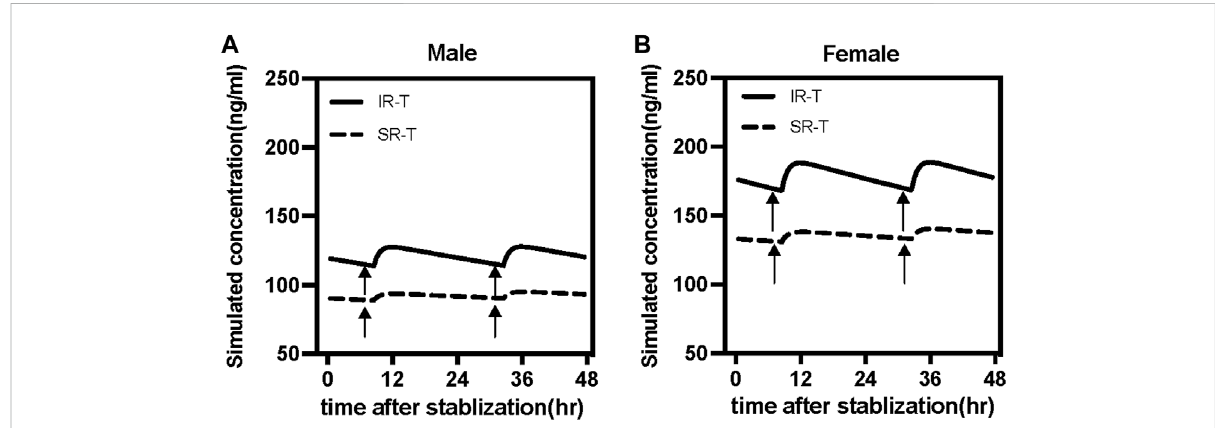
FIGURE 5 Simulated time courses of paroxetine serum concentration at steady-state under 50 mg daily dose for immediate-release tablet (IR-T, black lines) and sustained-release tablet (SR-T, black dash lines) in males (A) and female (B) . Black arrows represent the routine sampling time of TDM (7: 00